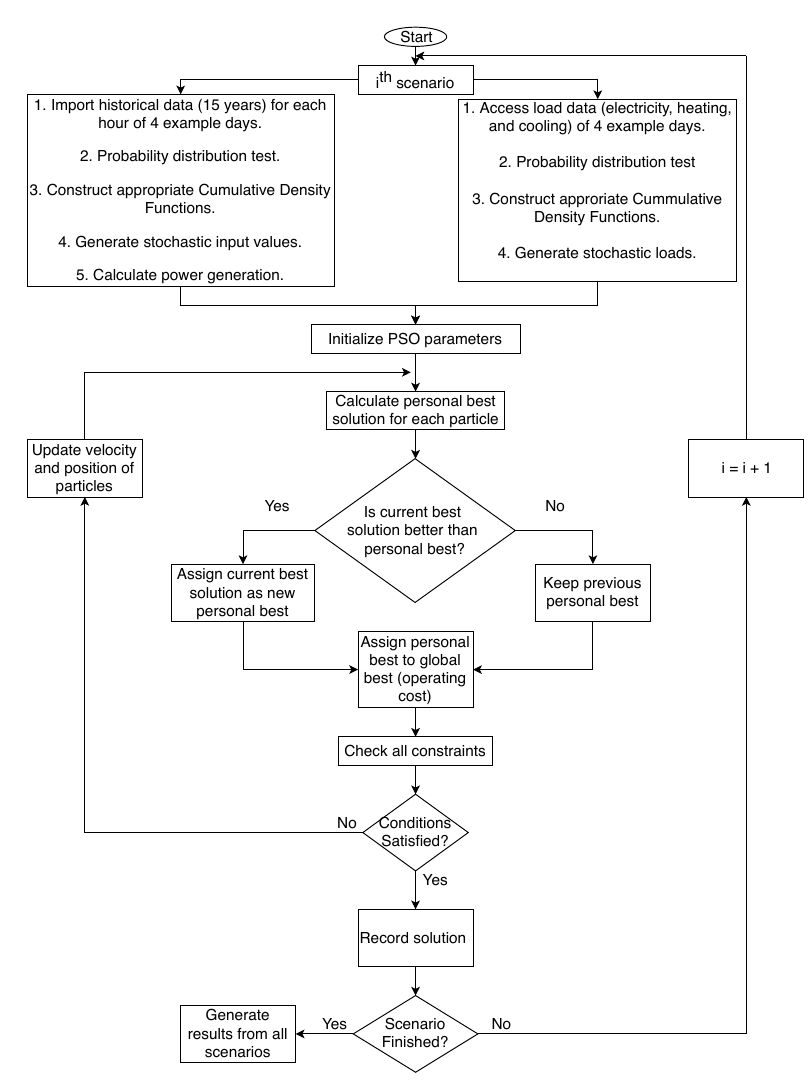
Figure 7. Flowchart of the Monte Carlo simulation and the Particle Swarm Optimization